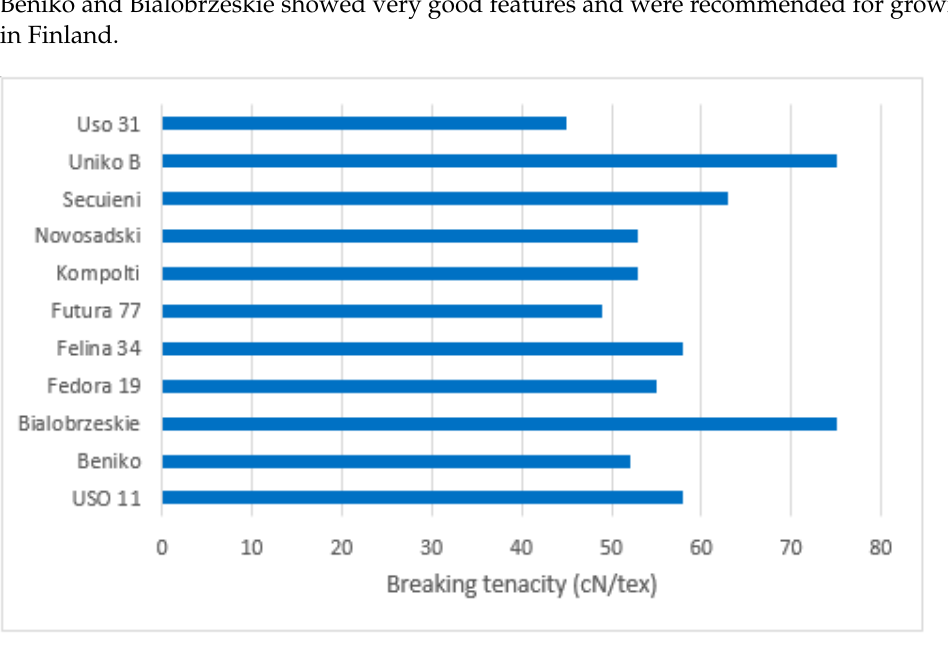
Table 3. Characteristics of hemp fibres based on the different resources of literature 1 [44], 2 [43], 3